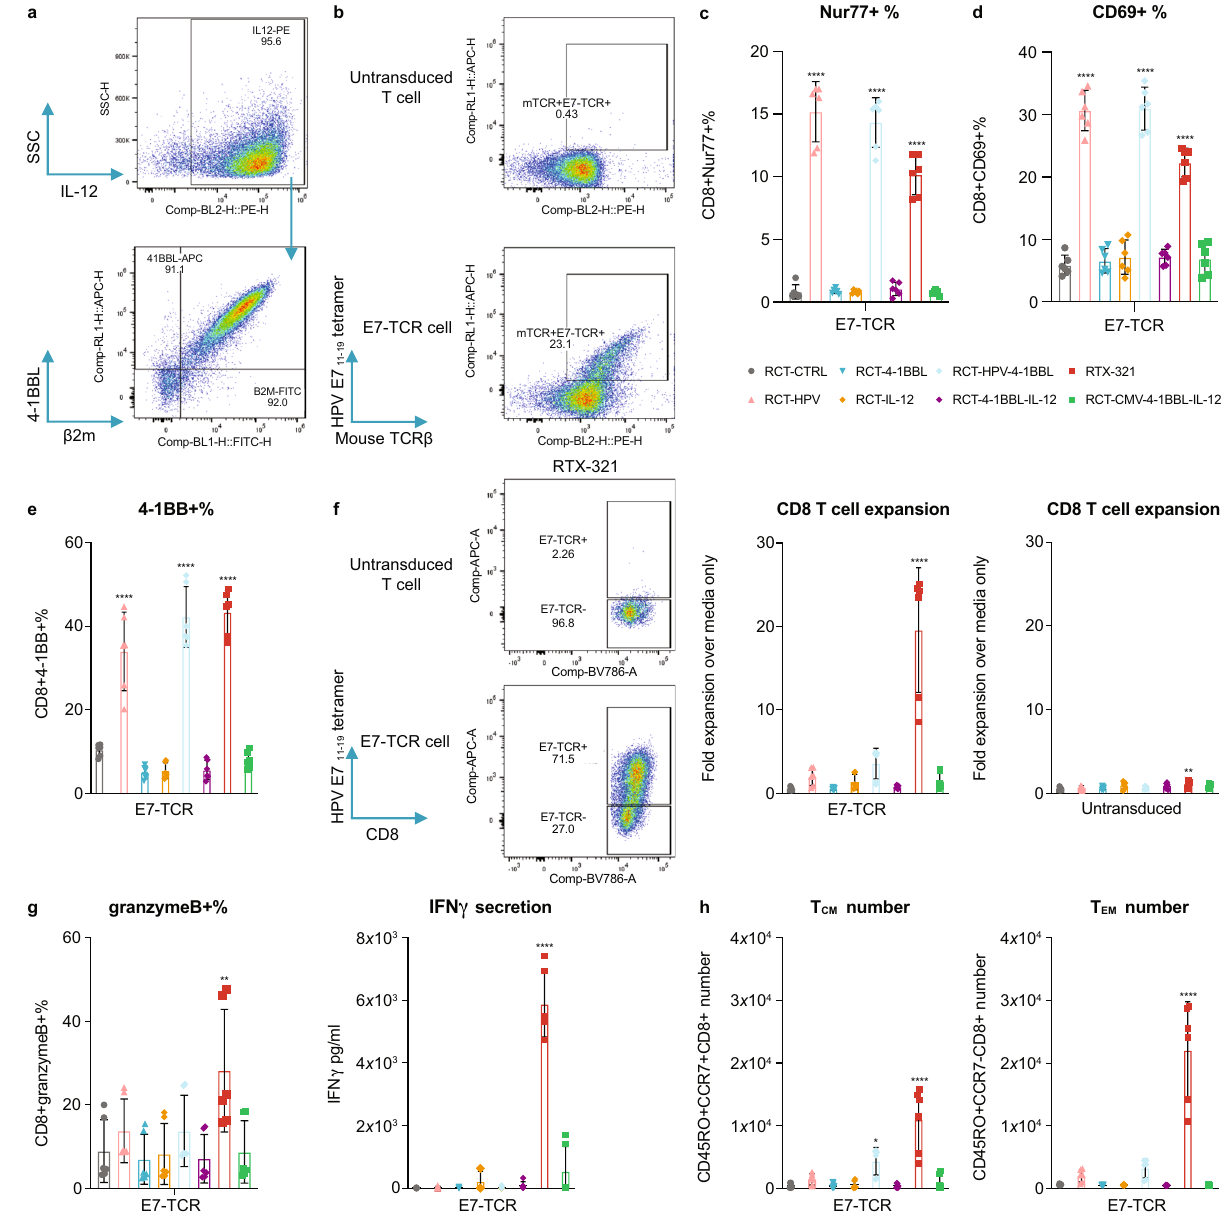
Fig. 6 RTX-321 drives primary antigen-speci fi c T-cell expansion, activation, memory differentiation, and effector function in vitro. a RTX-321 expression by anti-IL-12, anti-4-1BBL, and anti- β 2M staining. b Representative fl ow plots showing TCR expression of E7-TCR cells compared with untransduced T cells before co-culture. c – h E7-TCR cells (duplicates from three donors) were incubated with RCT-CTRL, RCT-HPV, RCT-4-1BBL, RCT-IL- 12, RCT-HPV-4-1BBL, RCT-4-1BBL-IL-12, RTX-321, or RCT-CMV-4-1BBL-IL-12. The Nur77 + % at 2 h ( c ), CD69 + % at 24 h ( d ), and 4-1BB + % on day 5 ( e ) of E7-TCR cells. f Representative fl ow plots showing E7-TCR + expression of RCT-CTRL- and RTX-321-treated E7-TCR cells on day 5. Fold expansion of E7- TCR cells and untransduced CD8 + T cells over media-treated controls on day 5. g The granzyme B + % of E7-TCR cells on day 1 and IFN γ concentration in the supernatant on day 5. h T CM and T EM of E7-TCR cell numbers on day 5. One-way ANOVA compared to RCT-CTRL; Nur77 + % ( c ), CD69 + % ( d ), and 4- 1BB + % ( e ): RCT-HPV, RCT-HPV-4-1BBL, or RTX-321 P < 0.0001; CD8 T-cell expansion ( f ): RTX-321 E7-TCR P < 0.0001, untransduced P = 0.0062; granzymeB + % ( g ): RTX-321 P = 0.0021; IFN γ secretion ( g ): RTX-321 P < 0.0001; T CM number ( h ): RCT-HPV-4-1BBL P = 0.011, RTX-321 P < 0.0001; T EM number ( h ): RTX-321 P < 0.0001. Data are depicted as mean ± s.d and are representative of two independent experiments. Source data are provided as a Source Data fi